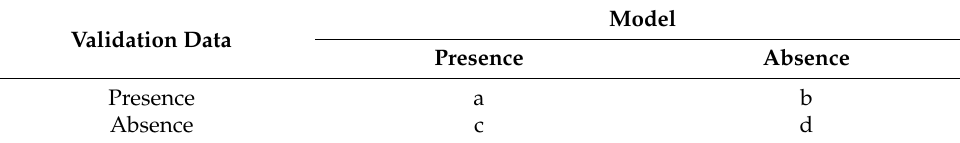
Table 3. Confusion matrix for binary